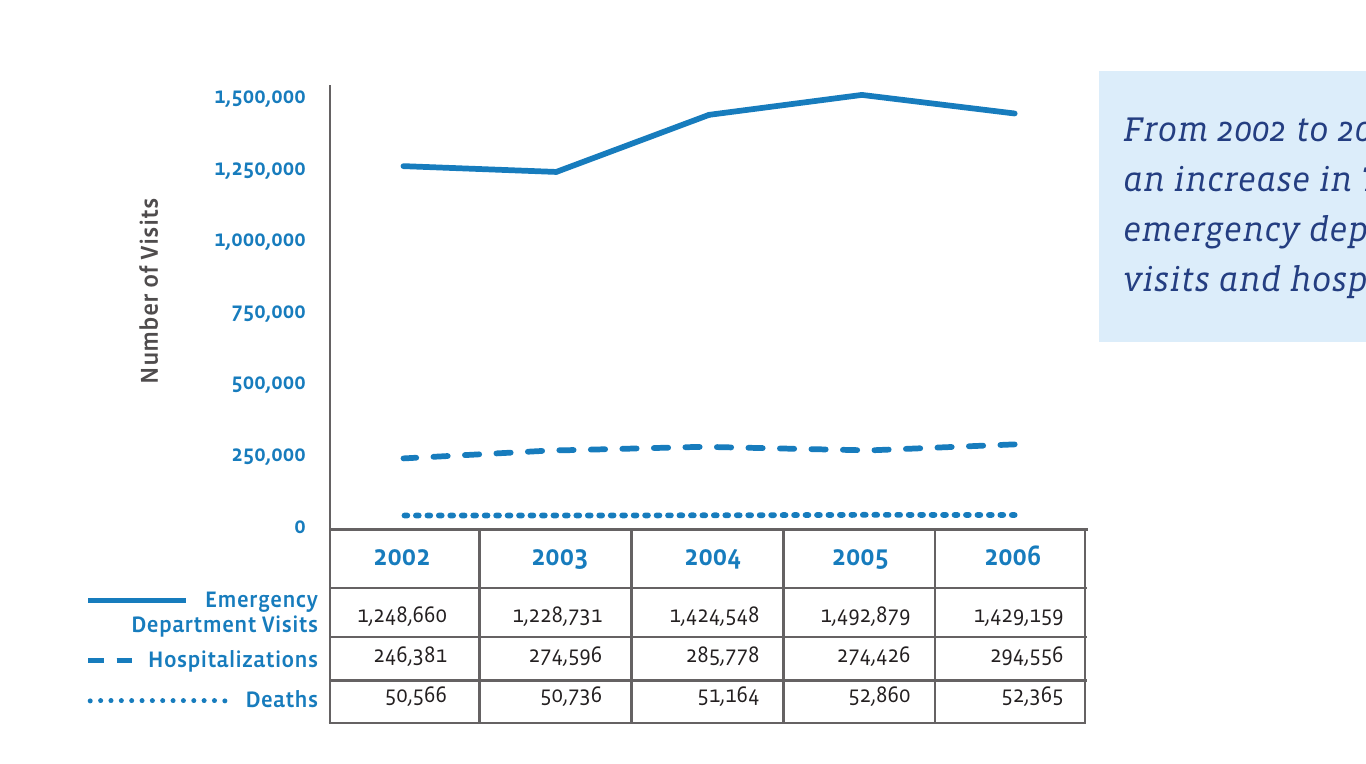
FIGURE 8: Annual Estimates of All Traumatic Brain Injury-Related Emergency Department Visits, Hospitalizations, and Deaths, United States,